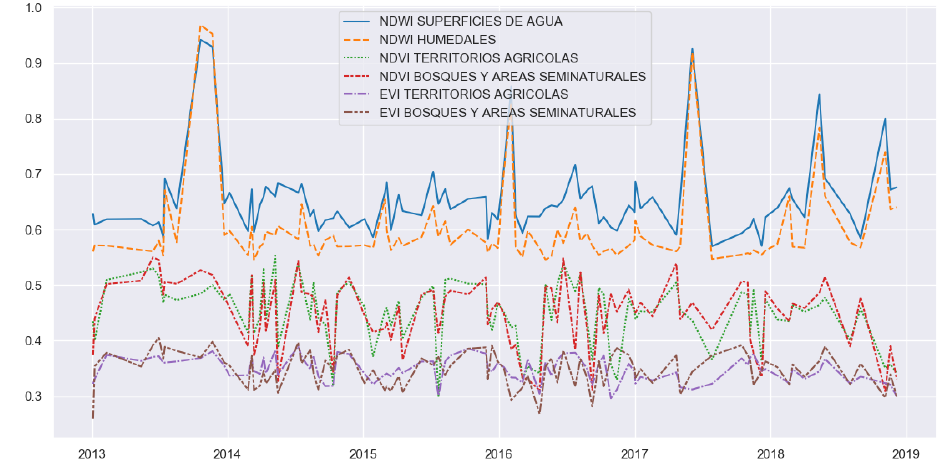
Fig. 2. Trend of the average values of the vegetation and water indices used